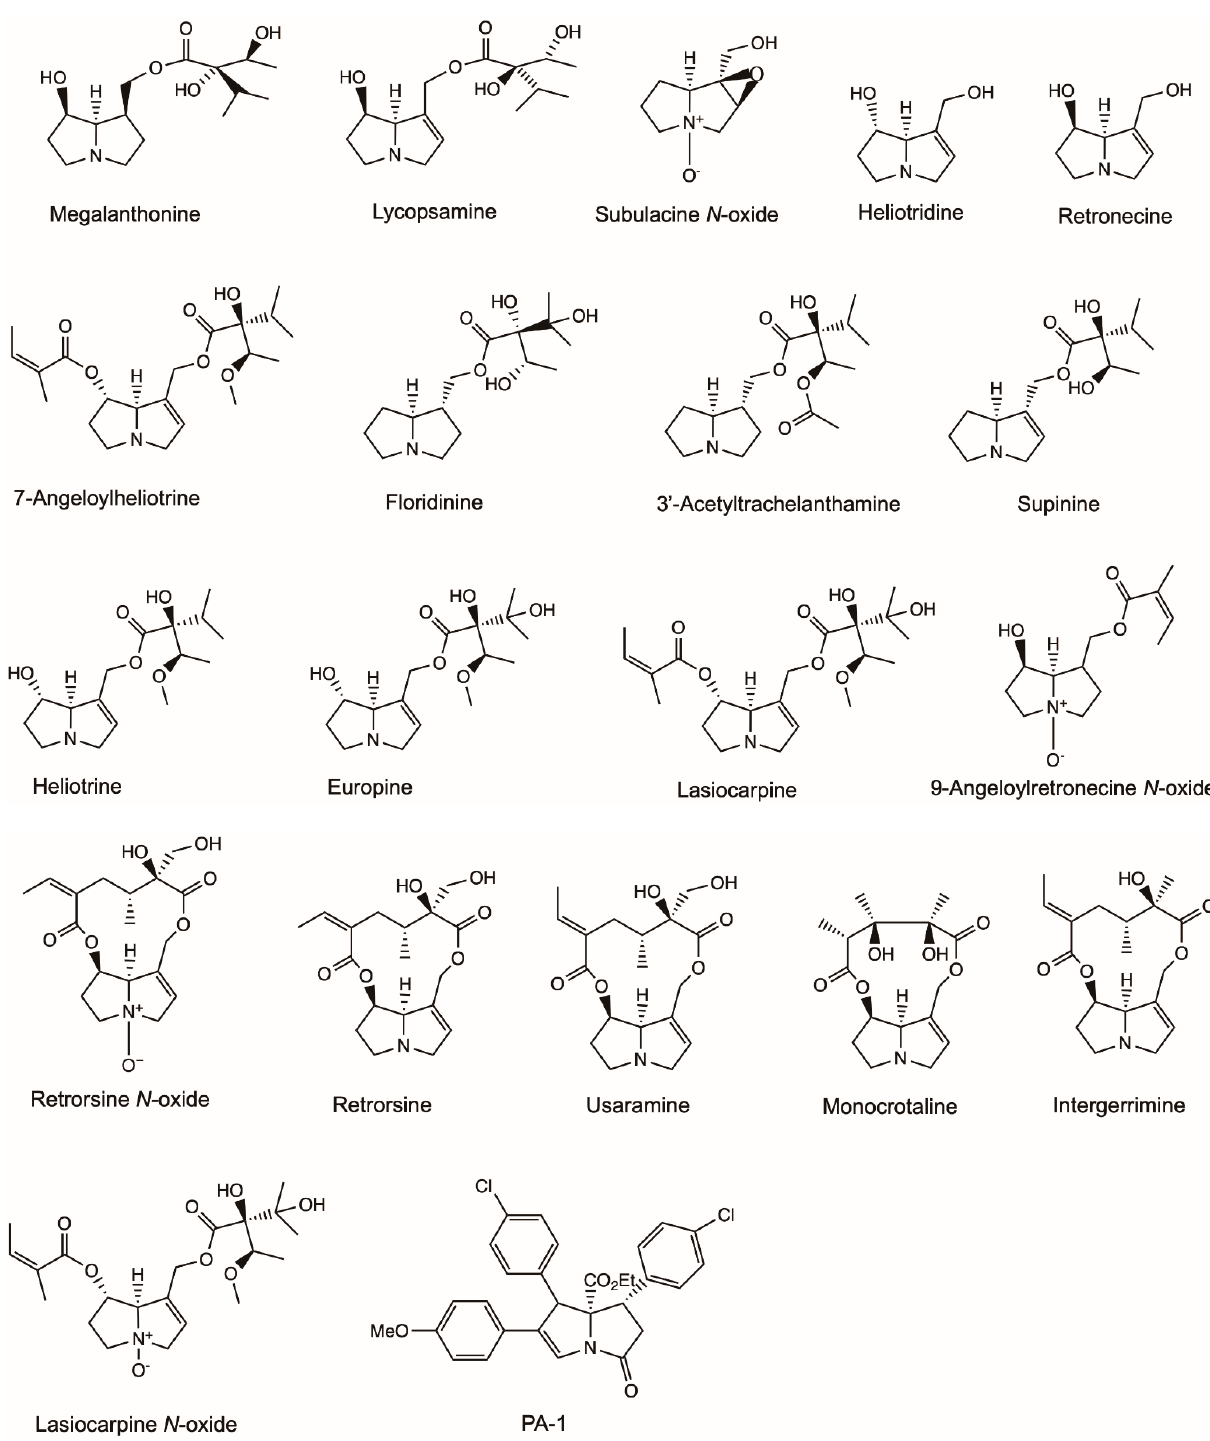
Figure 3. Structures of pyrrolizidine alkaloids that showed anti-microbial activity in this review. Singh et al. [30] isolated subulacine N -oxide, 7-Angeloylheliotrine, retronecine and heliotrine from H. subulatum (Figure 3). All four isolated PAs demonstrated pronounced activities to the selected microorganisms, including bacteria ( E. coli , Streptococcus pneu- moniae , B. subtilis , Bacillus anthracis and Staphylococcus aureus ) and fungi ( Aspergillus fu- migatus , A. niger , Rhizoctonia phaseoli and Penicillium chrysogenum ). 7-Angeloylheliotrine possessed maximum activity to E. coli and P. chrysogenum with a total inhibition area of 16.13 ± 0.116 mm and 11.61 ± 0.268 mm,